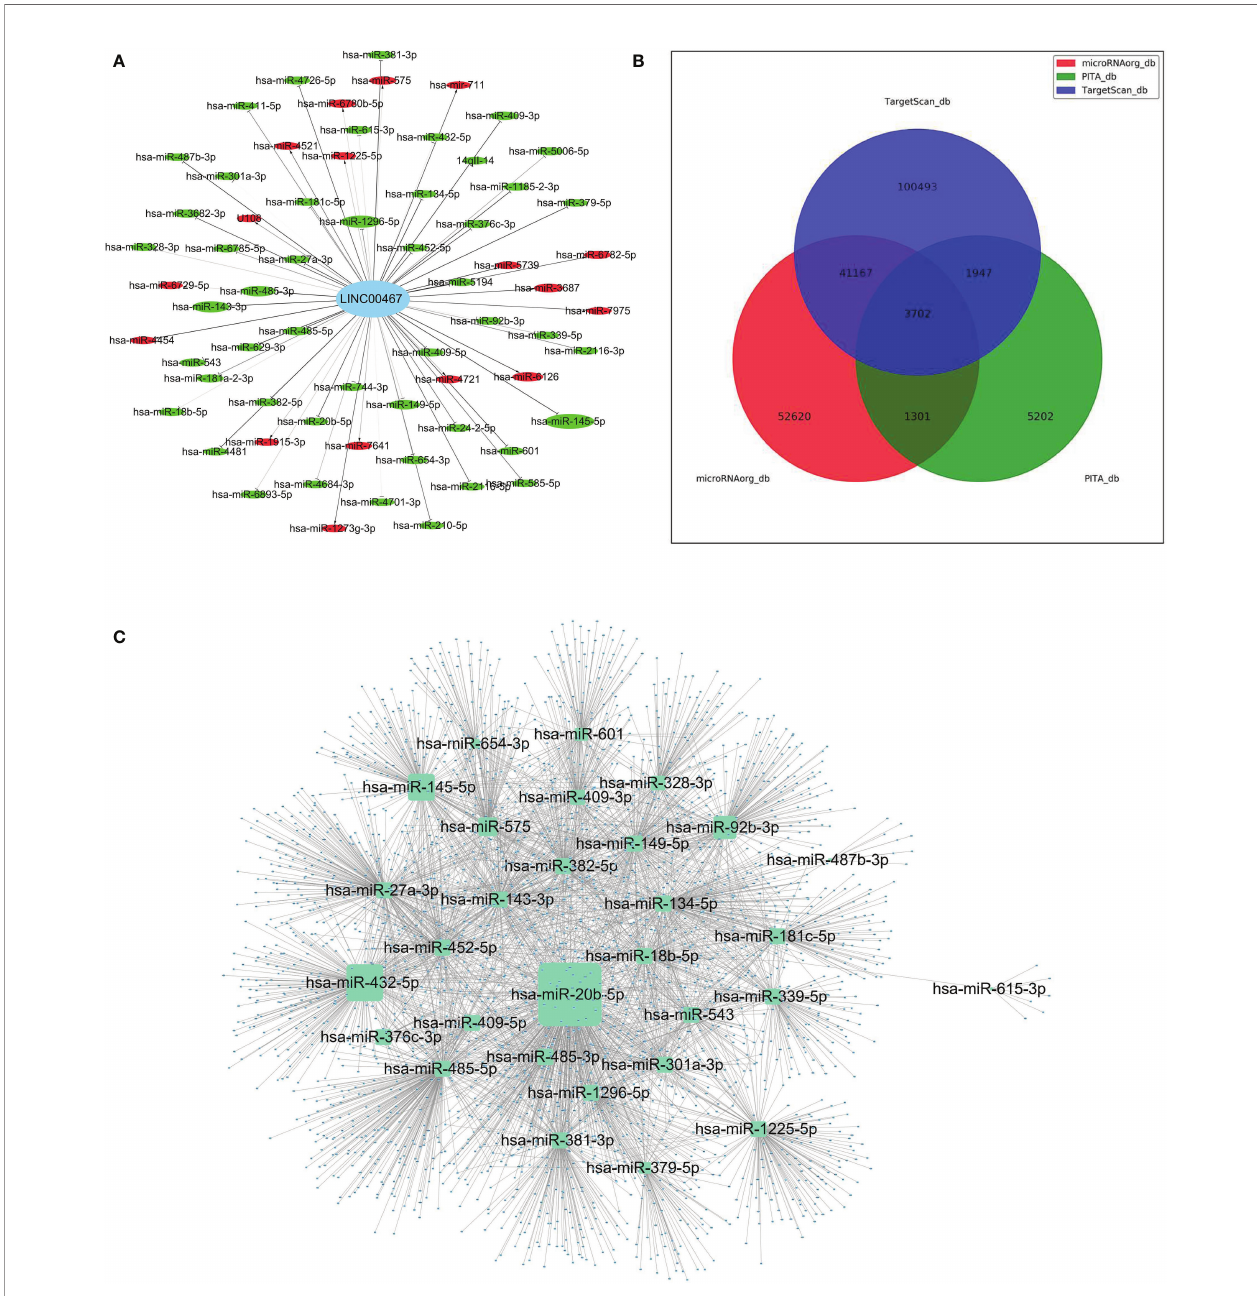
FIGURE 5 | The construction of a LINC00467-mediated competing endogenous RNA (ceRNA) network. (A) Global view of LINC00467-mediated network in differentially expressed miRNAs. Down-regulated miRNAs are marked green, while up-regulated miRNAs are marked red. The size of the node represents the degree of differential expression: the higher the degree, the larger the node. (B) Potential target genes of the differentially expressed miRNAs as predicted by the three software (PITA, MicroRNA.org, and TargetScan) as represented by a Venn diagram. (C) The interaction network of target genes as predicted by all three software and its corresponding